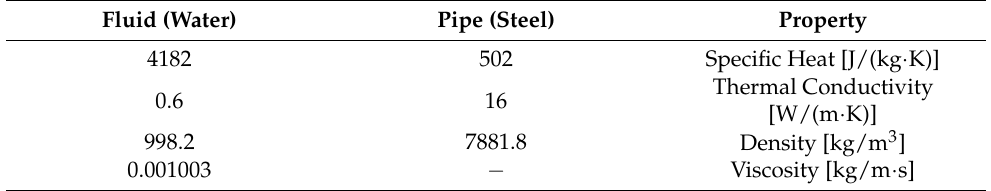
Table 3. The thermos–physical properties of materials [46]. Fluid